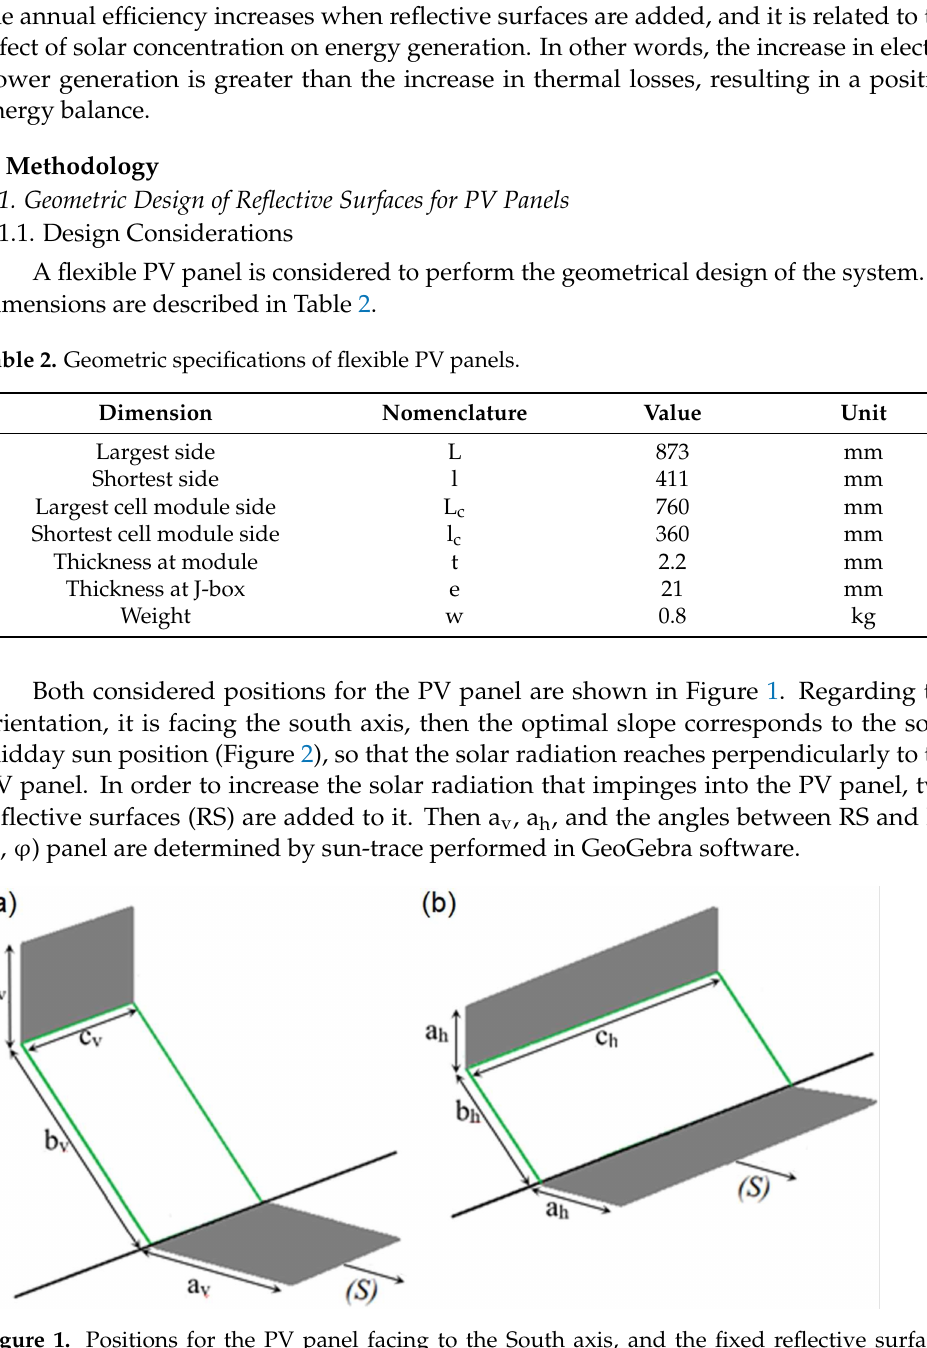
Figure 1. Positions for the PV panel facing to the South axis, and the fixed reflective surfaces. ( a ) vertical position. ( b ) horizontal